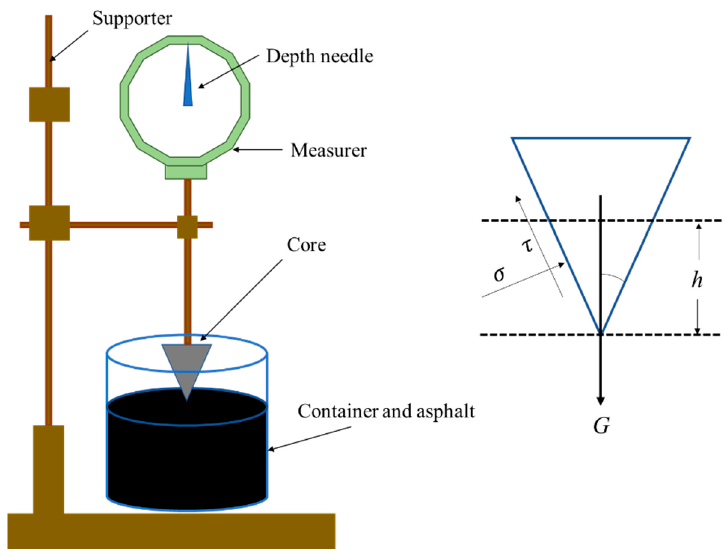
Figure 5. Schematic diagram of cone penetration test.